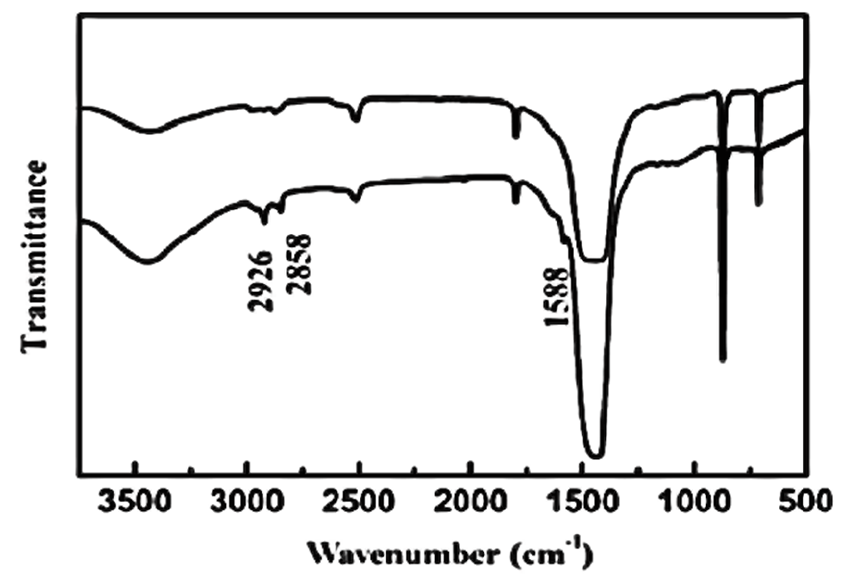
Figure 10. Fourier transform infrared spectra of calcium carbonate nanoparticles adapted from Chen et al.,